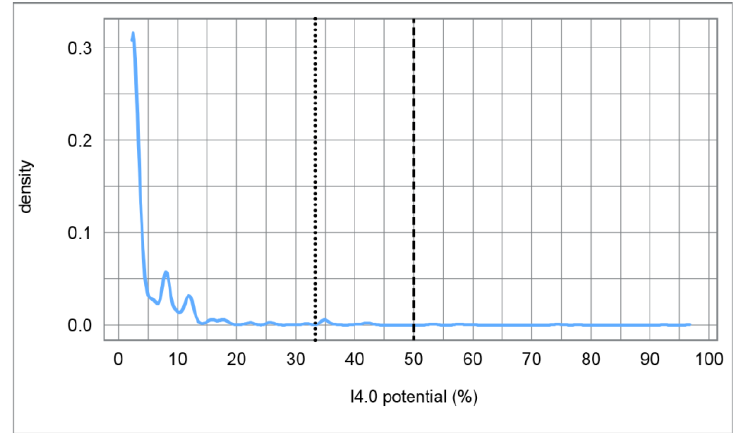
Figure 5. I4.0 potential distribution density function.